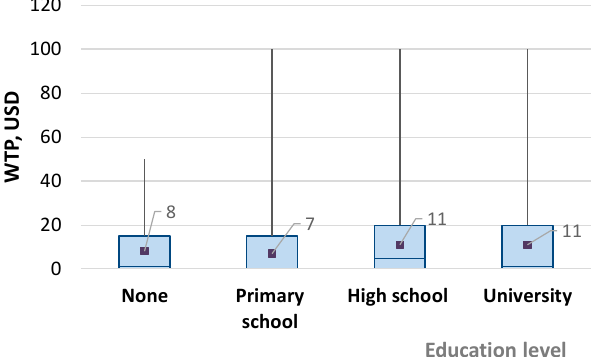
Figure 7. Box-plots for the correlation between WTP and education level of the respondents (the bullet represents the average value for each category).